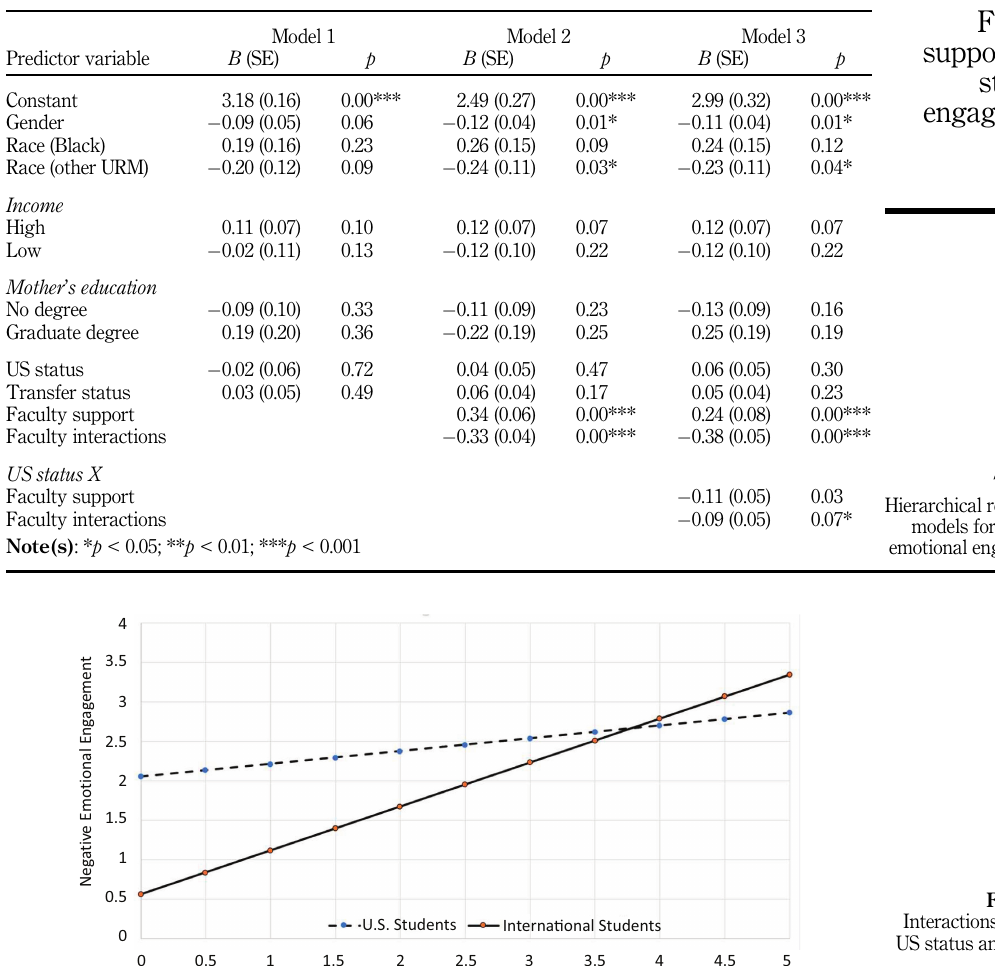
Figure 4. Interactions